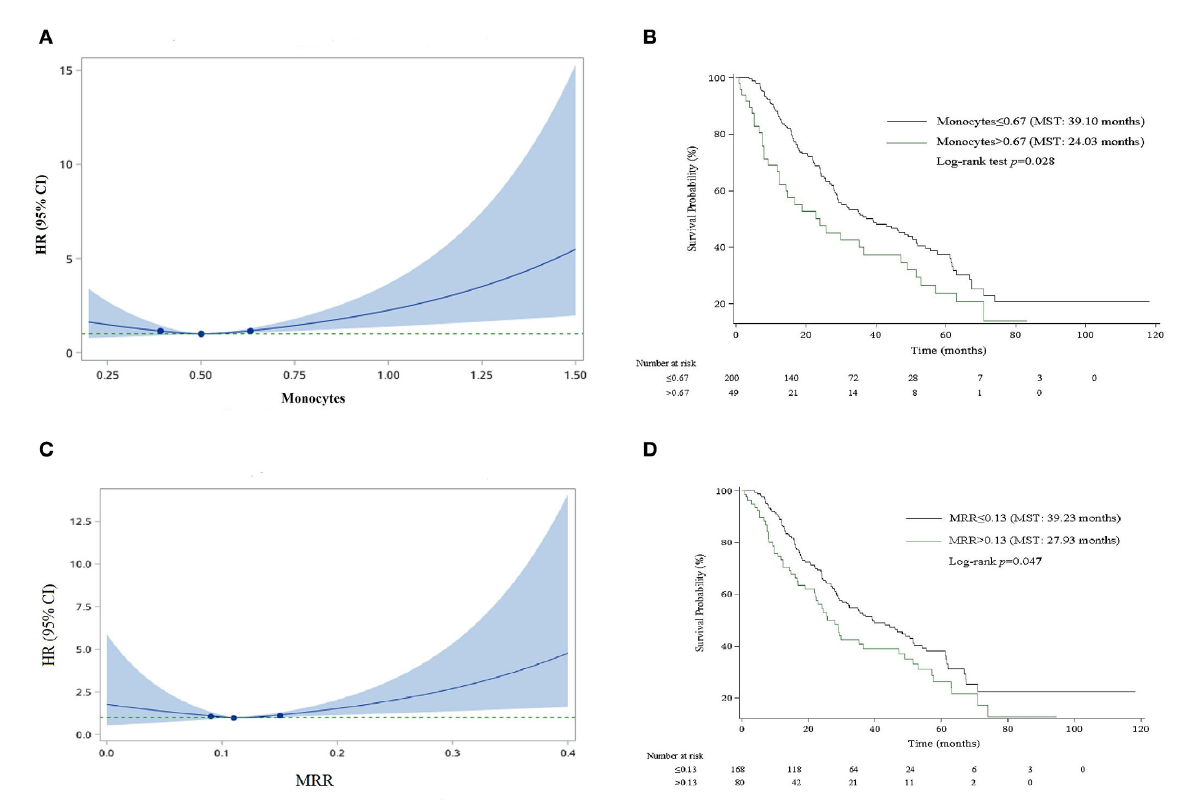
FIGURE1 Smooth curve and Kaplan–Meier survival curves for the relationship between monocyte and MRR and risk of mortality. (A) Smooth curve for monocyte. (B) Kaplan–Meier survival curve for monocyte. (C) Smooth curve for MRR. (D) Kaplan–Meier survival curve for MRR.